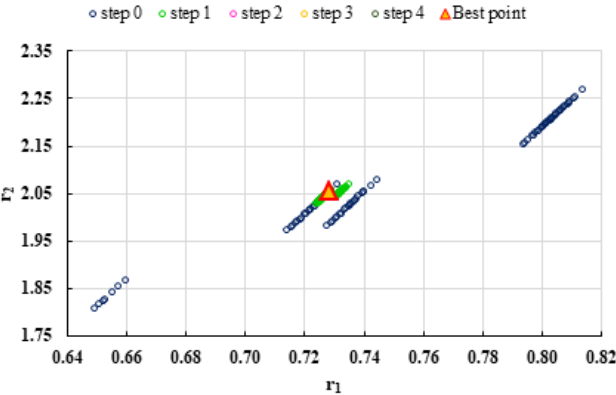
Figure 9. Distribution of P cen ( r 1 , r 2 ) points for each step of searching for the k-NN method for the conditions imposed by HC3.